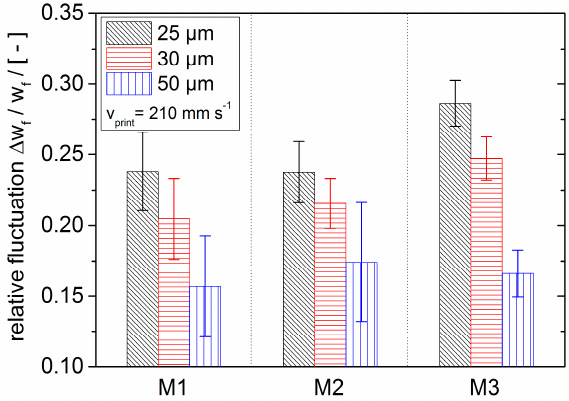
Figure 10. Degree of fluctuation in dried finger line width after screen-printing at v print = 210 mm s − 1 .